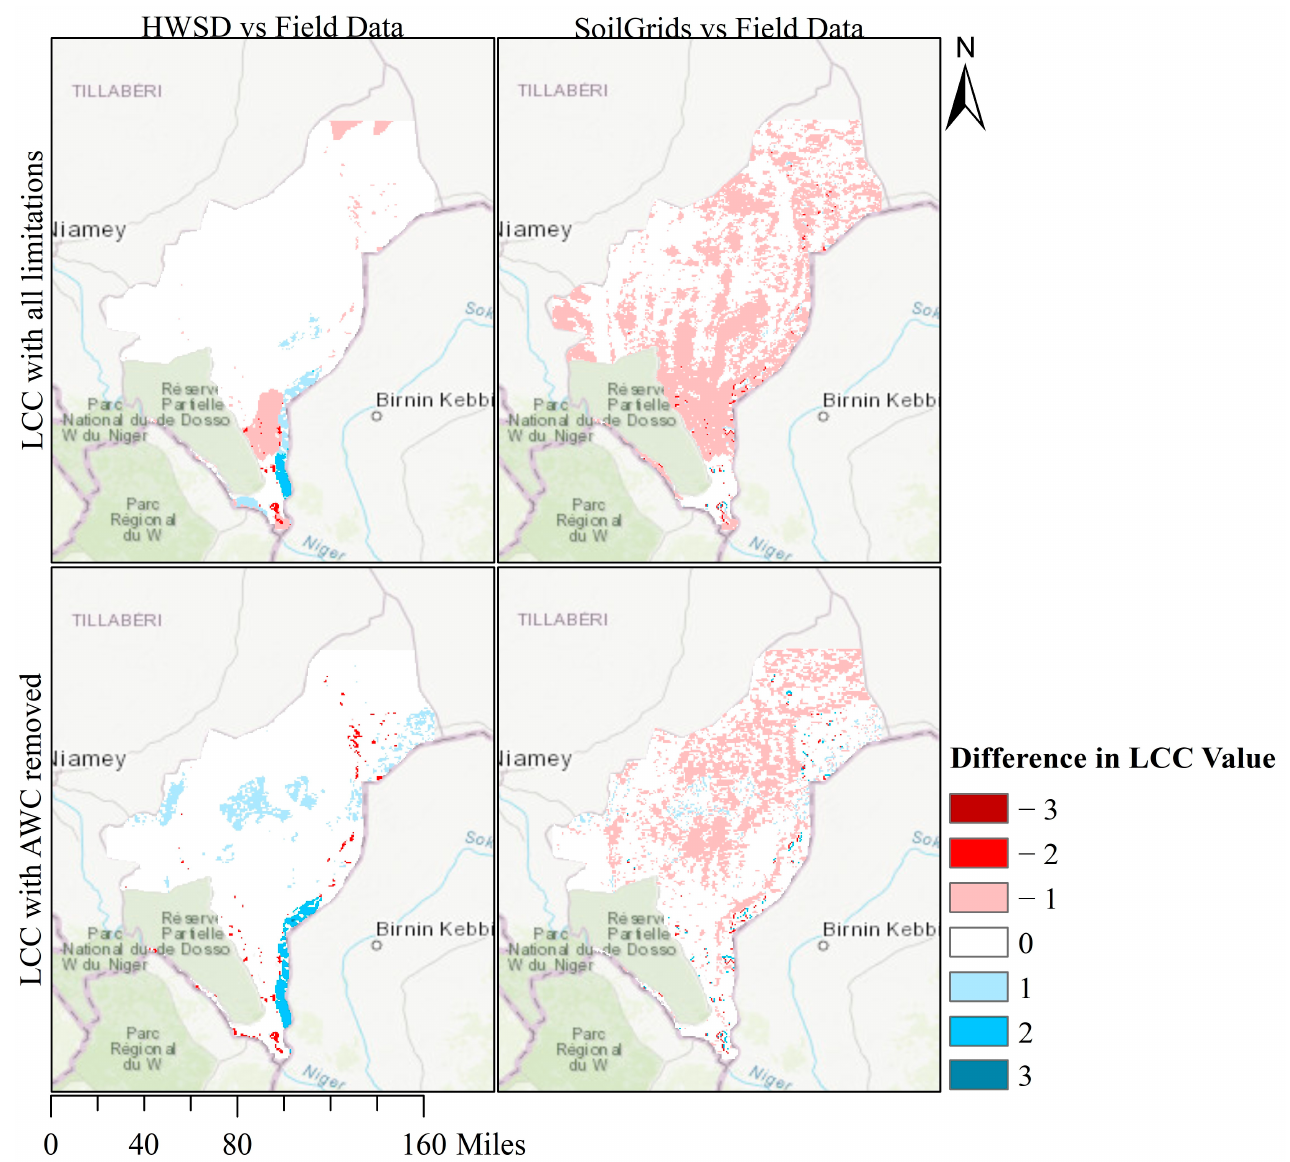
Figure 8. Difference between HWSD and field data LCC assessments (HWSD—field) and SoilGrids and field data LCC assessments (SoilGrids—yield) with and without AWC as a limitation. Positive numbers indicate an overestimation of LCC value by the digital products; negative numbers indicate and underestimation of LCC value. Table 10. Correlation coefficient between data sets on a pixel-by-pixel basis.